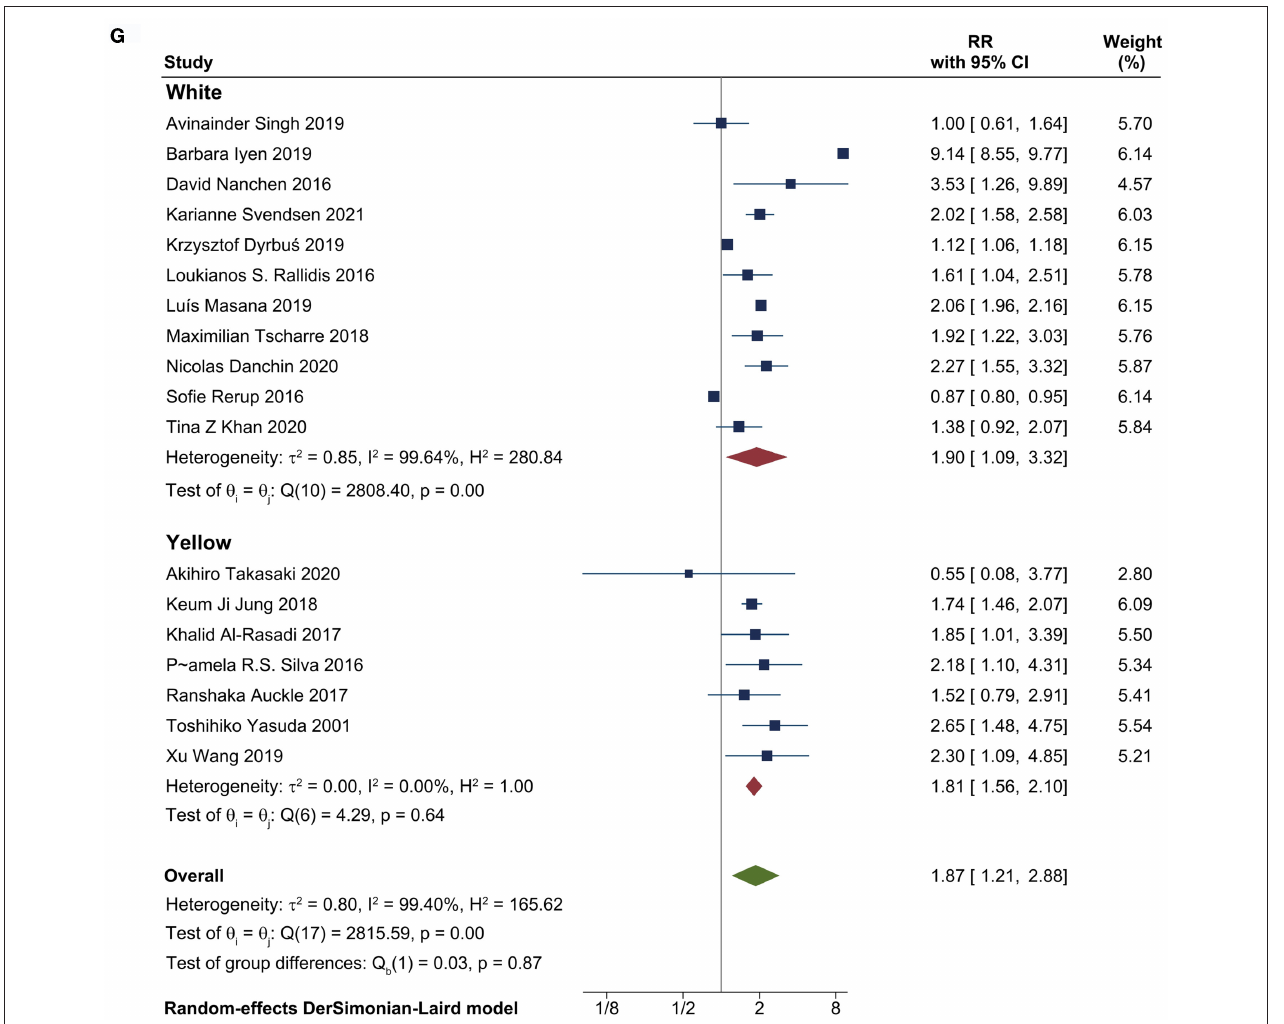
FIGURE 2 | Comparison of the incidence of prognostic events. (A) the overall pooled RRs of CVE and death in FH patients; (B) Adjusted HR and non-adjusted RR of CVE and death in FH patients. (C) RR of CVE, all-cause death and cardiac death; (D) RR of CVE and death in different cohorts, including general population, Hyperlipidemia population, CHD and ACS population; (E) RR of different diagnostic criteria; (F) RR of short-time and long-time follow-up; (G) RR of Whites and Asians.